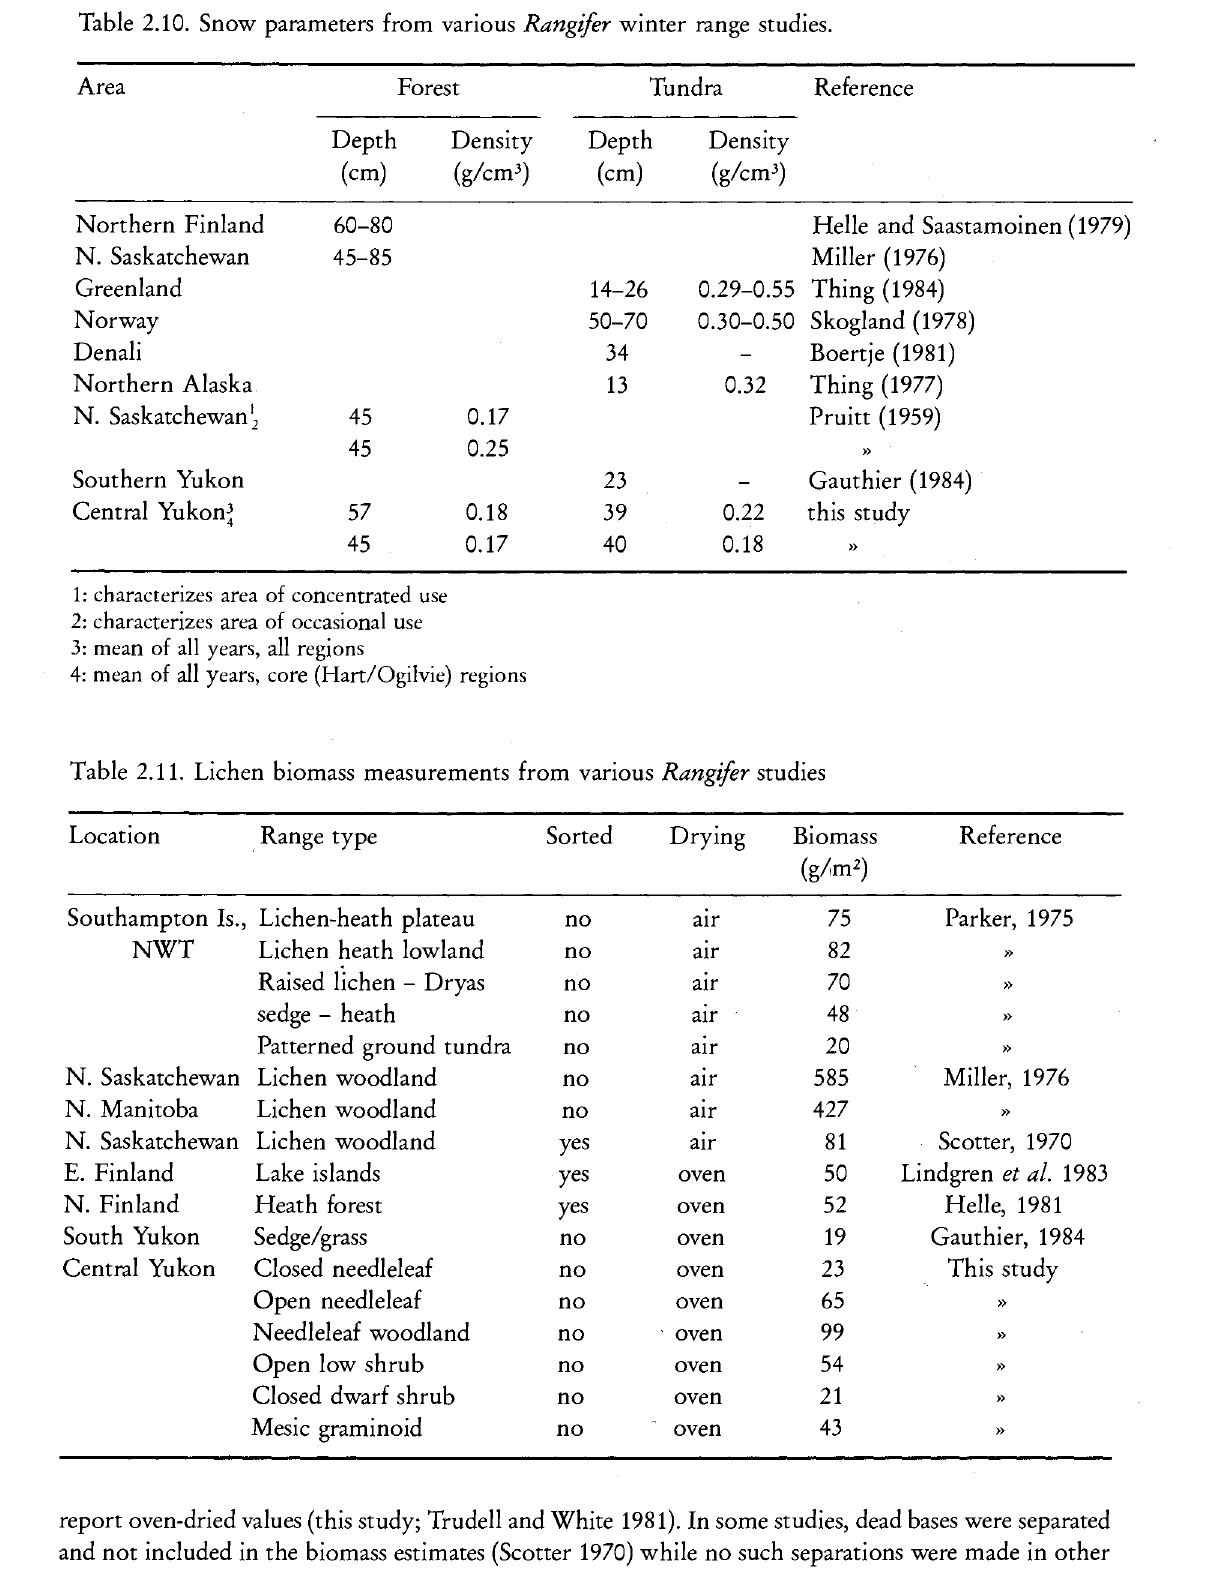
Table 2.10. Snow parameters from various Rangifer winter range studies.